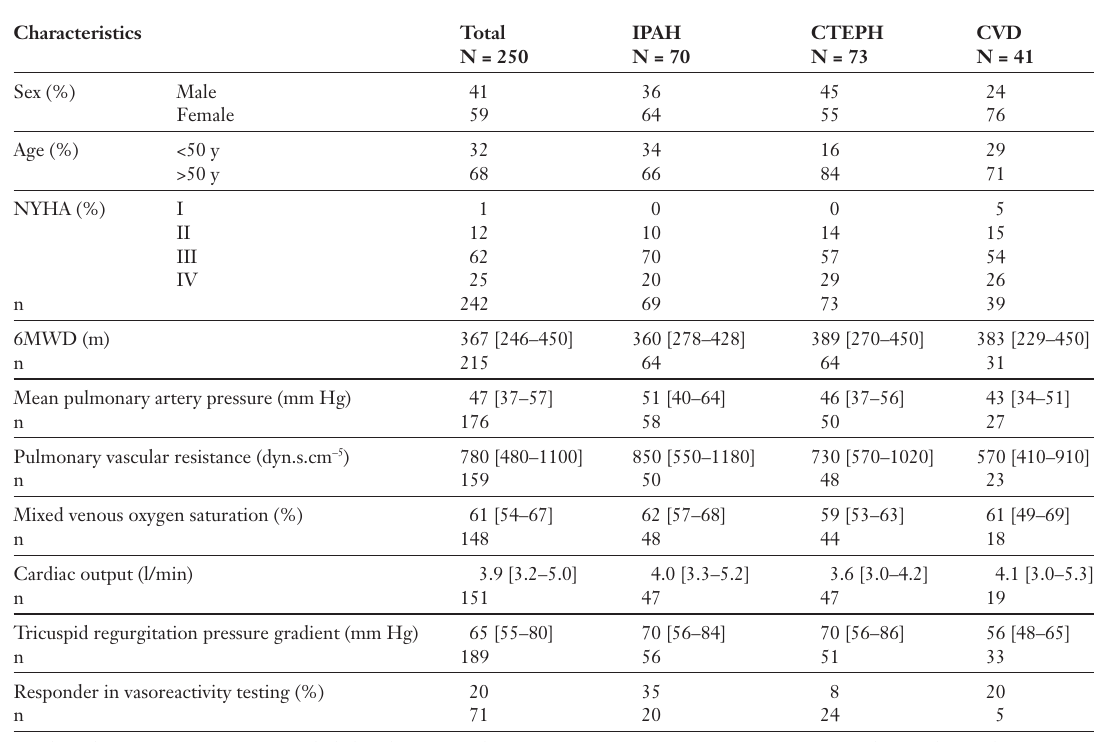
Table 3. Survival as a function of different base- line parameters is shown in figure 2.